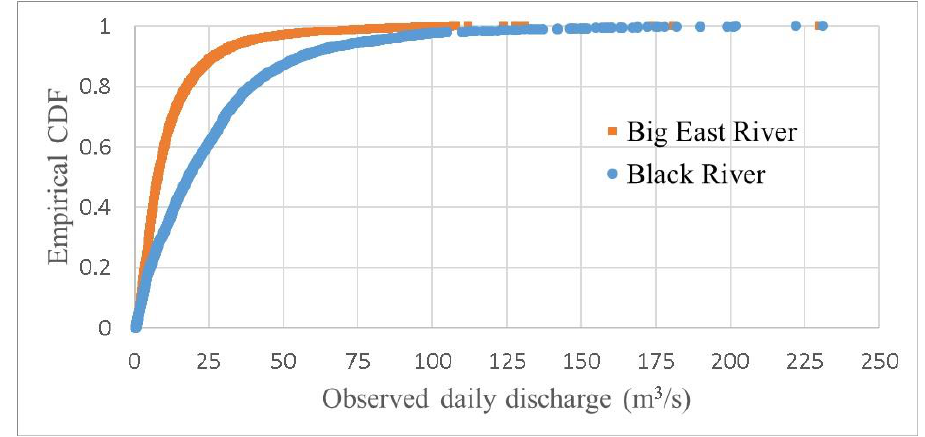
Figure 6. Empirical cumulative probability distribution of the daily streamflow observations at the outlet of the Big East River and Black River watersheds.